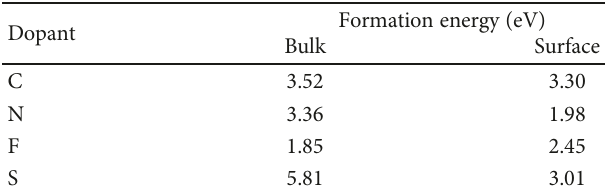
Table 2: Formation energy for anatase TiO group elements. Results obtained with the GGAU